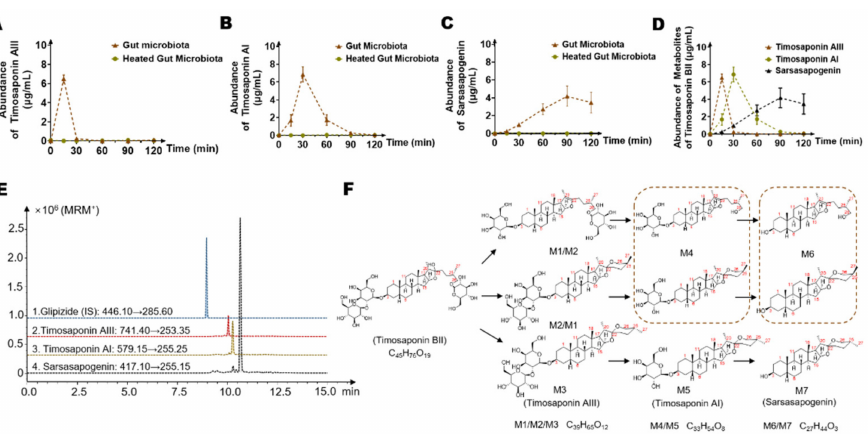
Figure 6. The level of possible timosaponin BII metabolites changed during incubation with rat intestinal bacteria after 0 min, 15 min, 30 min, 60 min, 90 min, and 120 min. ( A ) Metabolic curve of timosaponin AIII. ( B ) Metabolic curve of timosaponin AI. ( C ) Metabolic curve of sarsasapogenin. ( D ) The temporal characteristics of potential timosaponin BII metabolites by gut microbiota. ( E ) Ex- tracted ion chromatogram (EIC) spectra of timosaponin AIII, timosaponin AI, sarsasapogenin and the internal standard (Glipizide). ( F ) Metabolic pathway of timosaponin BII and possible